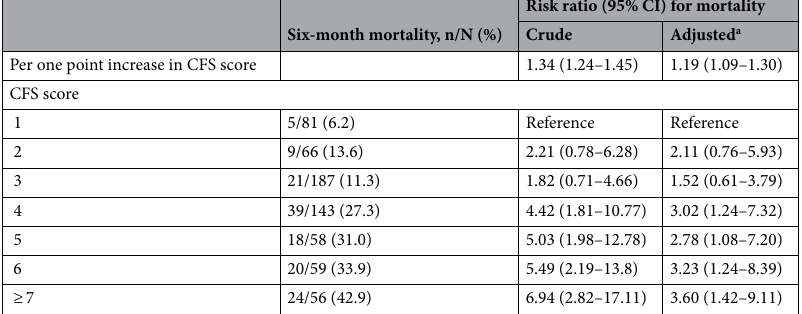
Risk ratio (95% CI) for